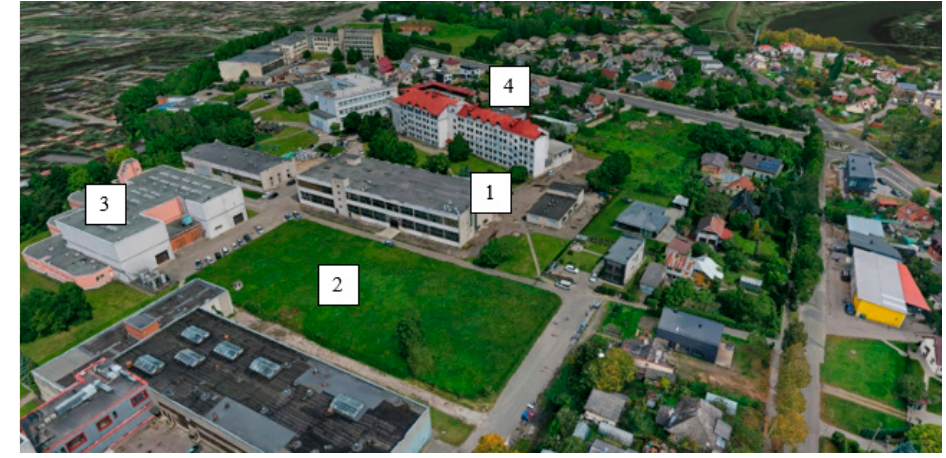
Figure 1. PV module locations: 1—flat roof, 2—ground, 3—south wall, and 4—pitched roof.